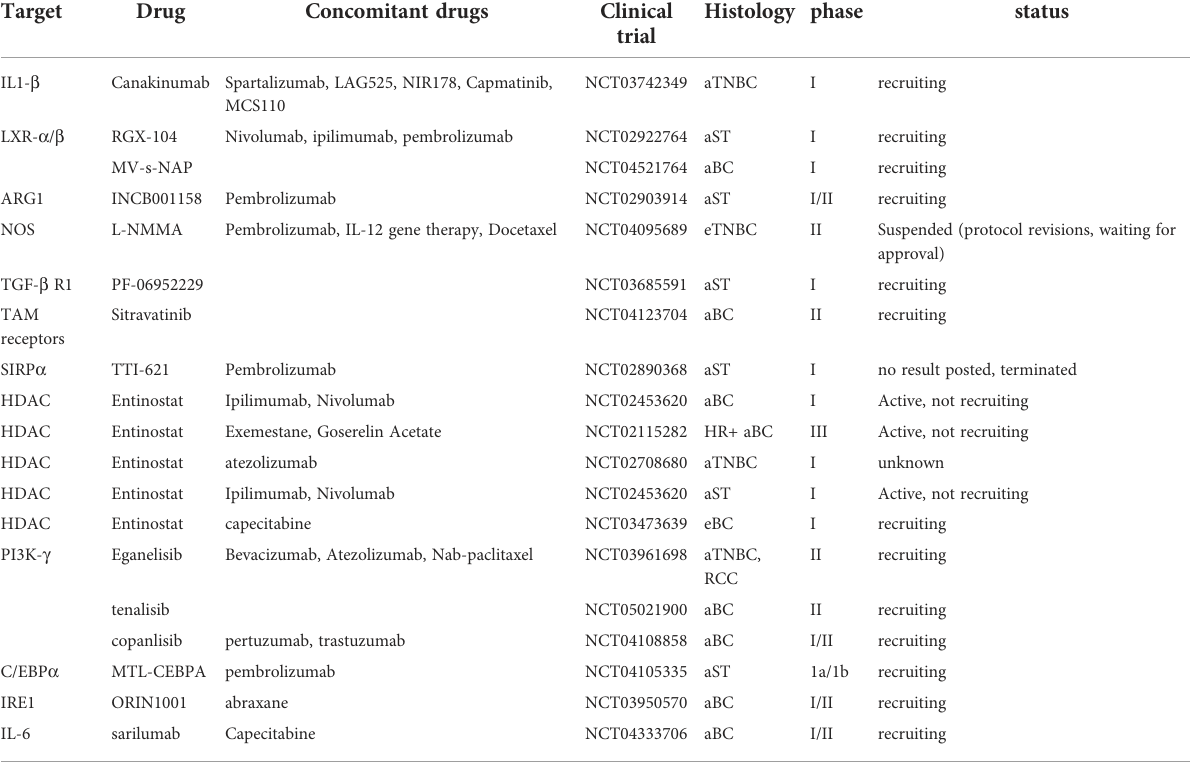
TABLE 3 Clinical trials with new treatment targeting neutrophils and MDSCs.